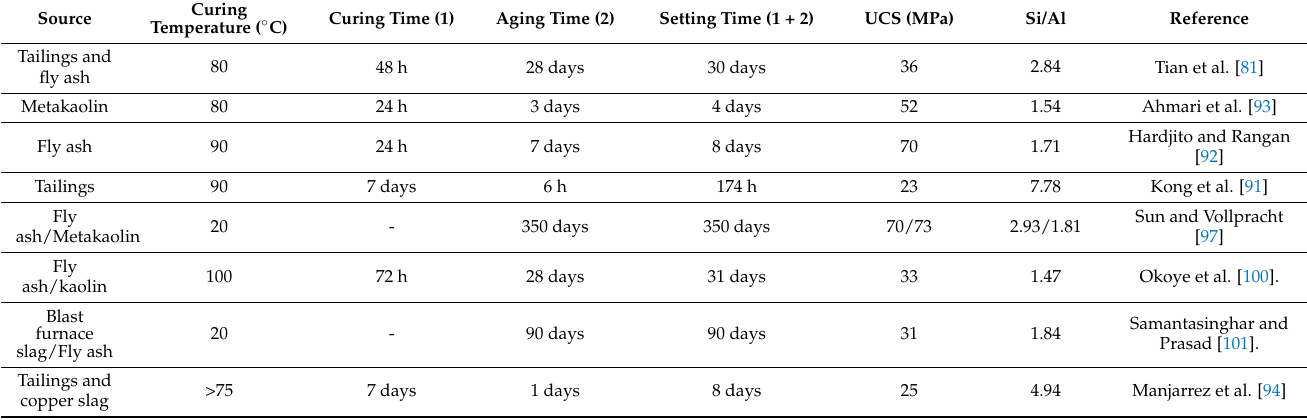
Table 5. BiblioDiagram compilation of optimal curing conditions based on different